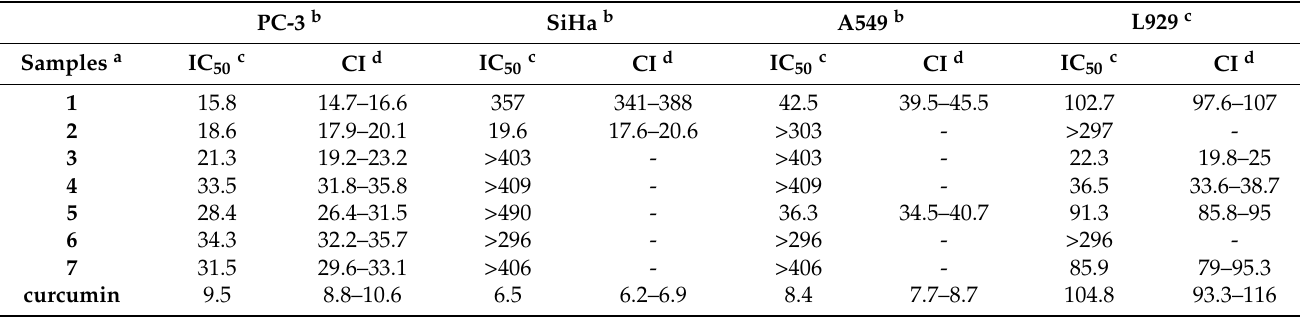
Figure 3. Structures of isolated compounds 1–7 after statistical pattern recognition from G. monspessulana seeds. Table 2. Anti-proliferative activity against cancer cell lines and fibroblasts of compounds 1 – 7 isolated from G. monspessulana seeds.